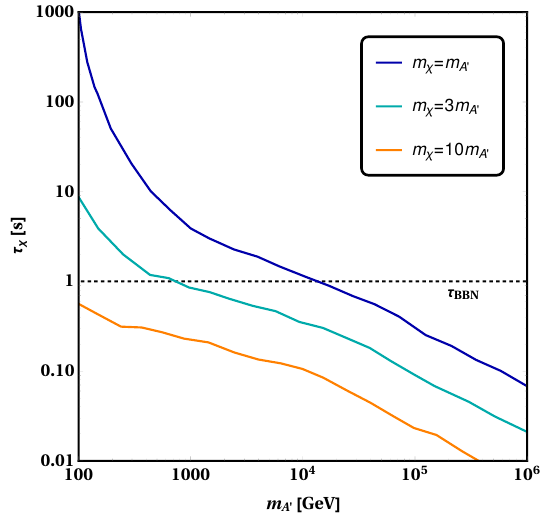
Figure 6 . Lifetime of the χ 1 , 2 for different ratios of m χ /m A 0 , given couplings equal to unity and the lowest value of m N allowed by